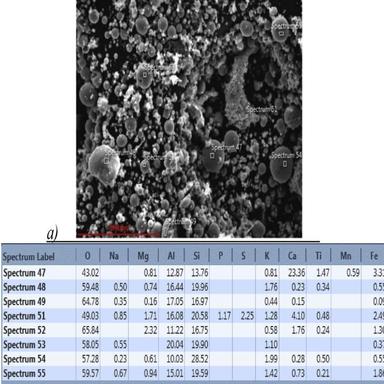
a) SEM image of the Fly Ash precursor morphology, before hydrothermal synthesis (segment: 100 mm). b) Elemental composition of different spots selected in the SEM image.